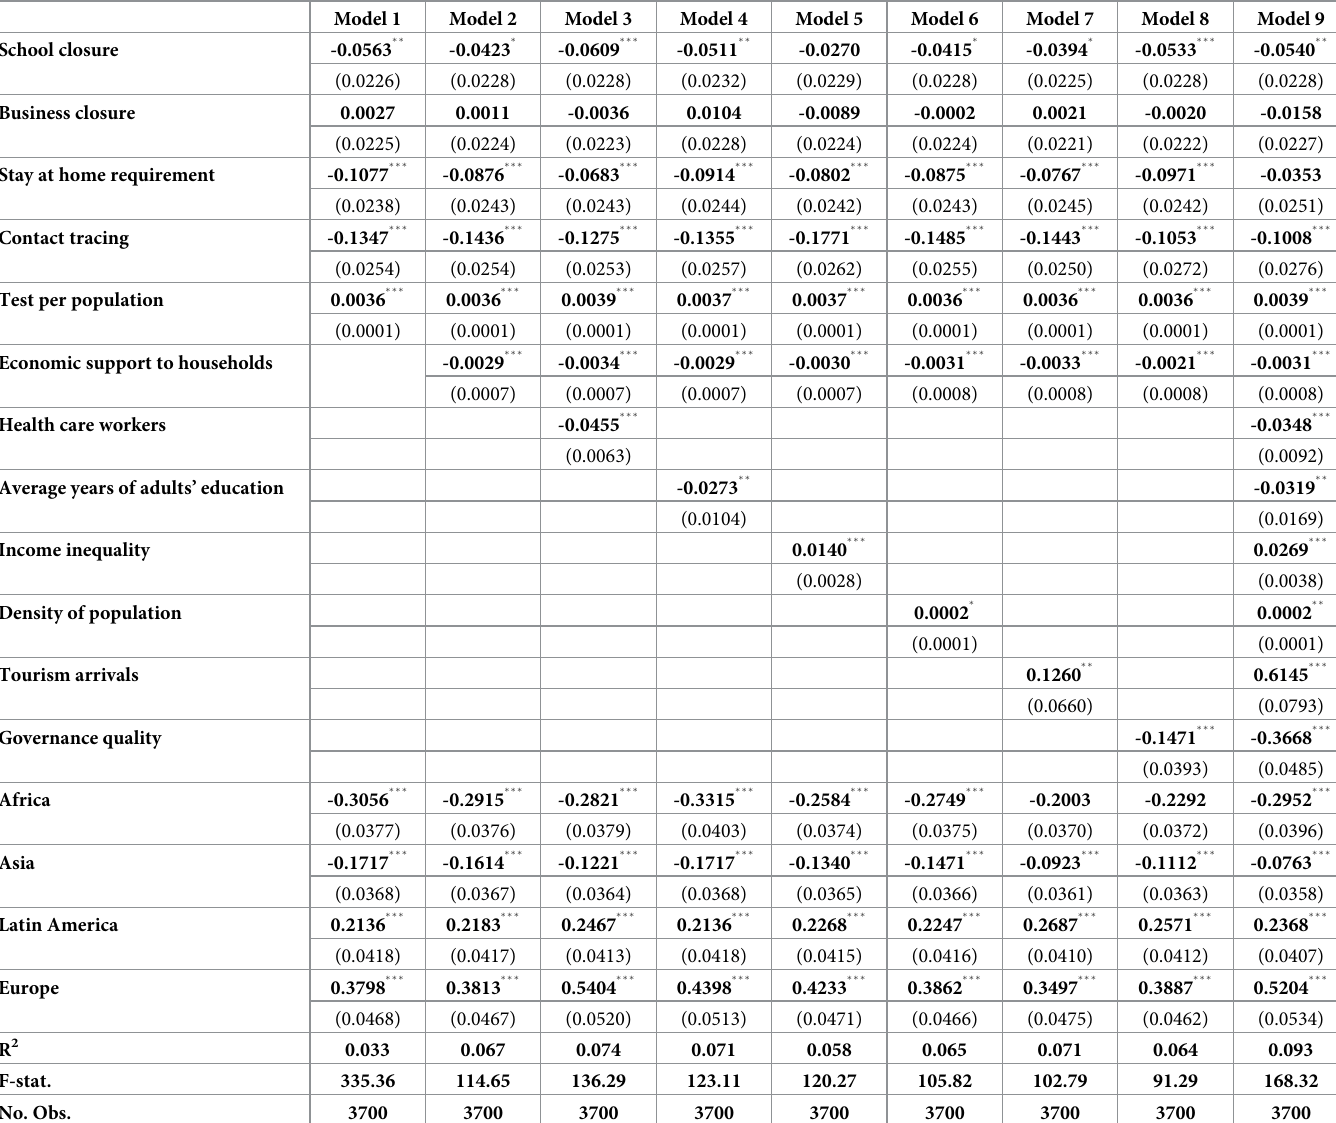
Table 3. Robustness test by applying the bootstrapping debiased